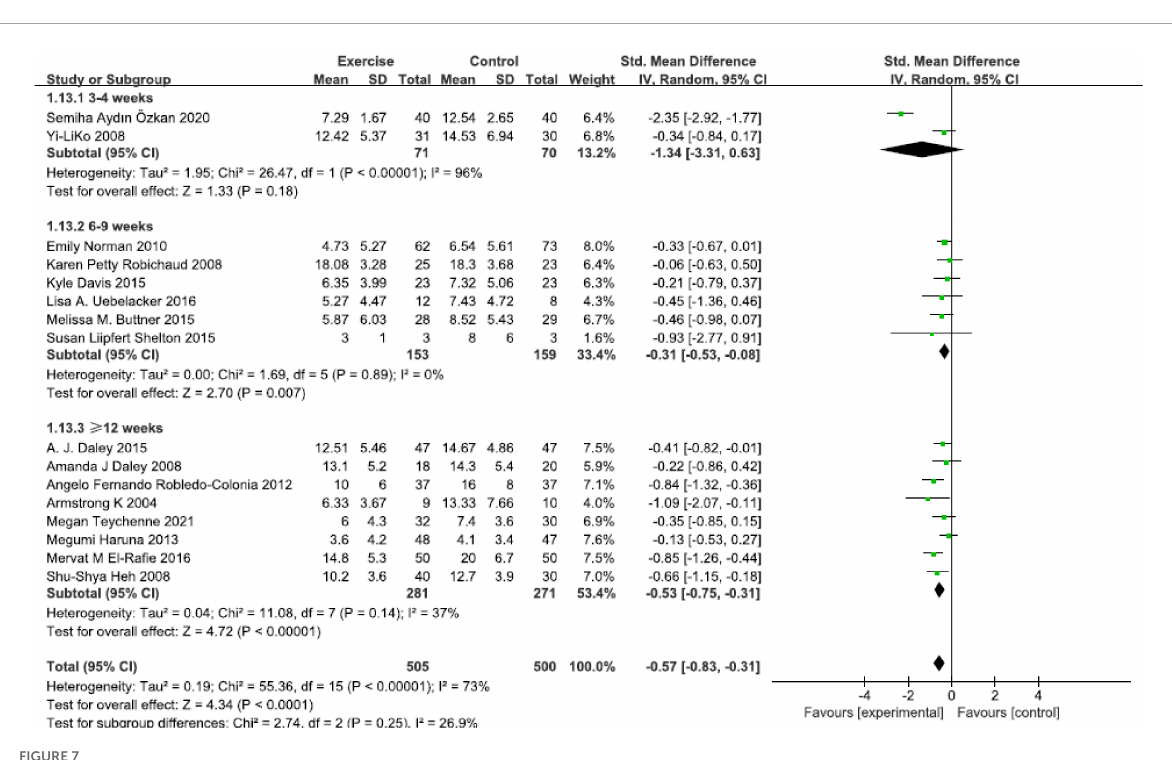
FIGURE7 Forest plot of the perinatal depression symptoms scores at different physical exercise intervention